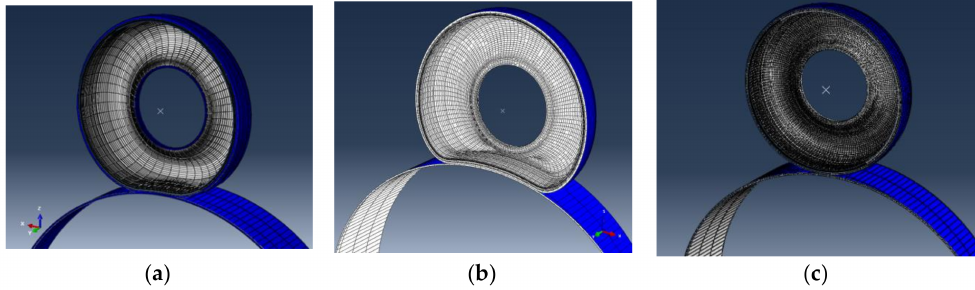
Figure 15. Different mesh options: Tire modeled using: ( a ) 51 elements, ( b ) 101 elements, ( c ) 181 elements.